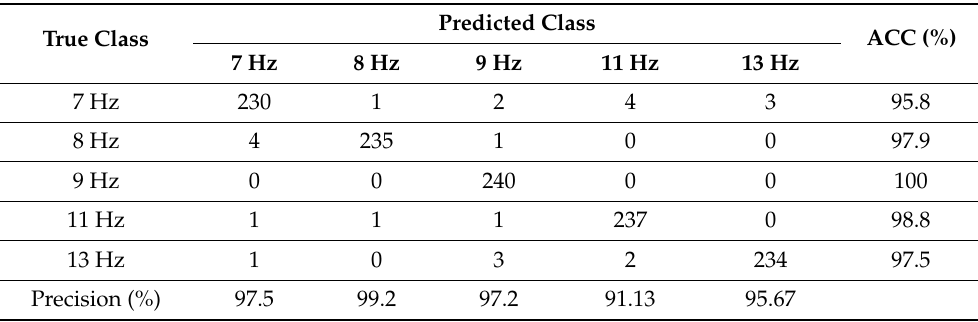
Table 7. The confusion matrix for the SSVEP recognition results using CCA classifier for the direction test in the second experiment (Scenario